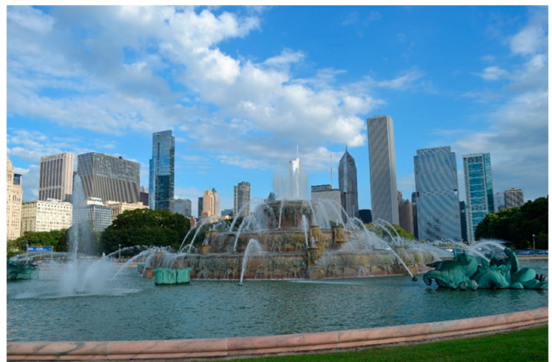
Figure 15. Centering Grant Park is the Buckingham Fountain. Built in 1927 and featuring an iconic art deco style, the fountain boasts being one of the largest in the world. Interestingly, study participants often photographed the Buckingham Fountain with the city skyline in the